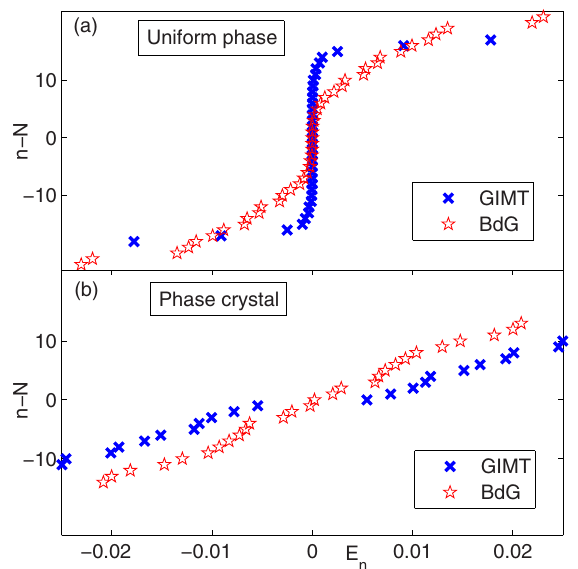
Fig. 3 Distribution of low-energy eigenvalues for clean sample. Eigenvalues E n within GIMT and BdG in the uniform phase ( a ) and phase crystal ( b ) states at a low temperature, T = 0.08 T c < T s < T * . Strong correlations generate a higher number of zero-energy states in the uniform phase in ( a ). The phase crystal state shifts most zero- energy states to fi nite energies within both BdG and GIMT, but GIMT displays larger shifts and a full energy gap ( min f E n g ¼ 0 : 006 ) due to the formation of co-existing s -wave state. Here, the eigenindex n is shifted by the total number of lattice sites N